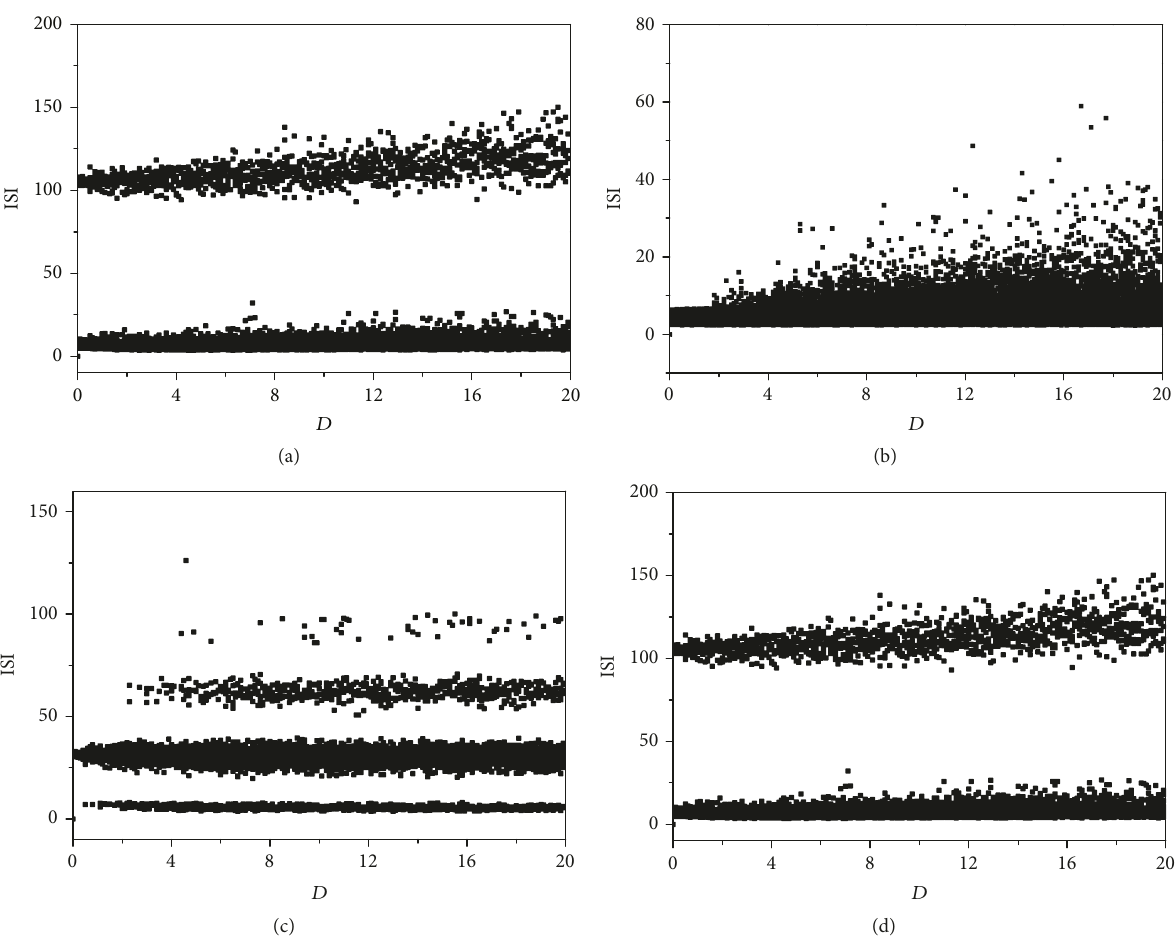
Figure 10: Bifurcation diagrams with the increasing of noise intensity 𝐷 . (a) 𝐴 = 1.6 , 𝐵 = 1.6 , 𝜔 = 0.04 , and 𝑁 = 50 . (b) 𝐴 = 1.6 , 𝐵 = 9.0 , 𝜔 = 0.04 , and 𝑁 = 50 . (c) 𝐴 = 1.6 , 𝐵 = 1.6 , 𝜔 = 0.2 , and 𝑁 = 50 . (d) 𝐴 = 1.6 , 𝐵 = 1.6 , 𝜔 = 0.04 , and 𝑁 = 300